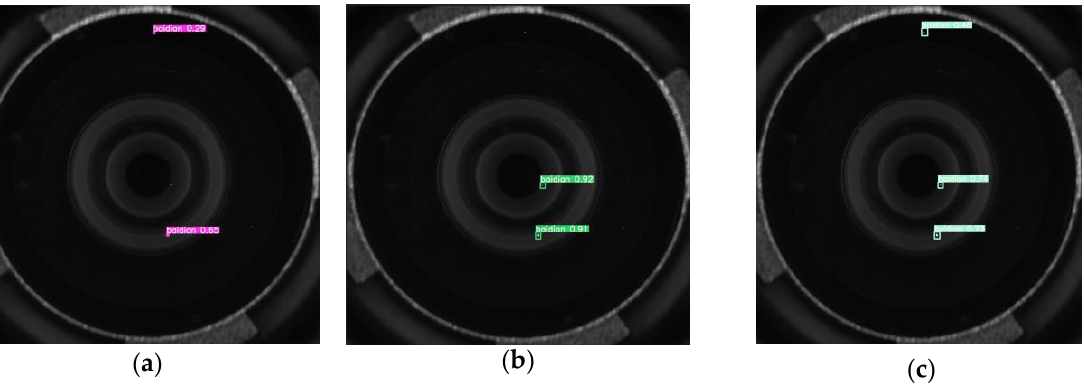
Figure 14. Comparison of ablation experiment results. ( a ) YOLOv5s+DAFS. ( b ) YOLOv5s+DAFS+DIoU-NMS. ( c ) YOLOv5s-Small-Target.